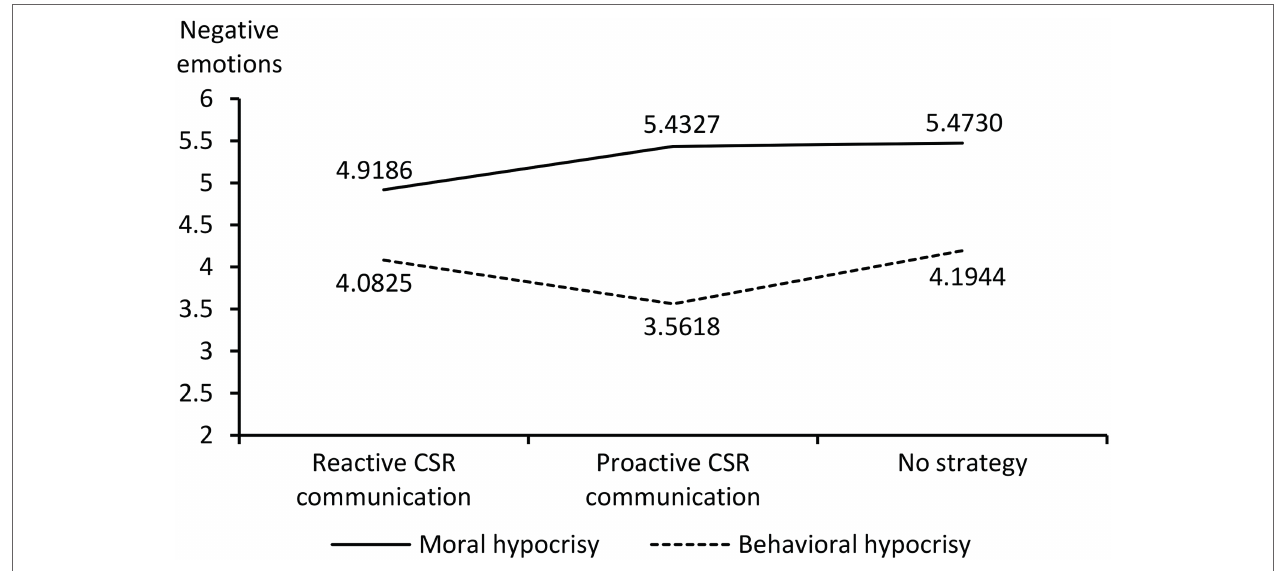
FIGURE 5 | Trend of negative